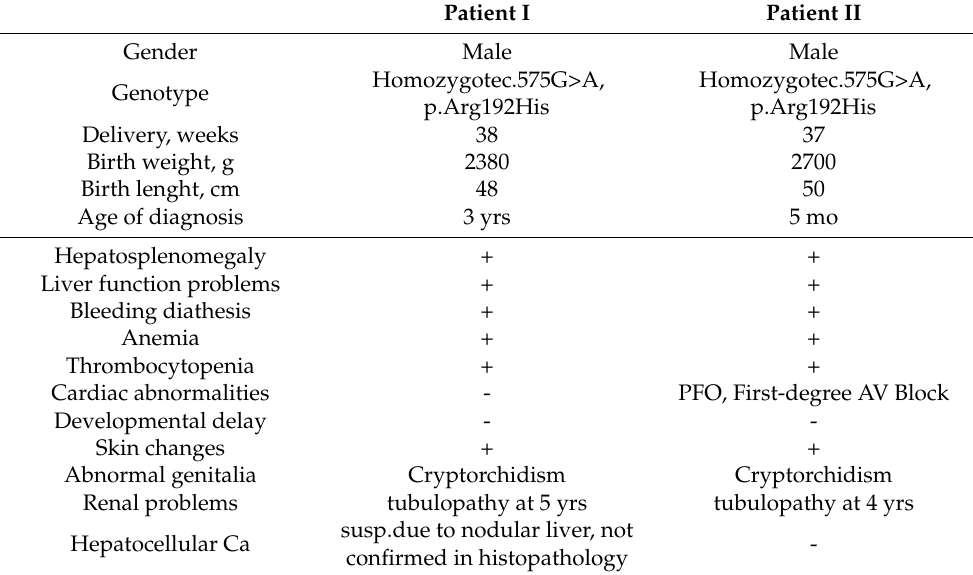
Table 1. Clinical course of Patients I and II before